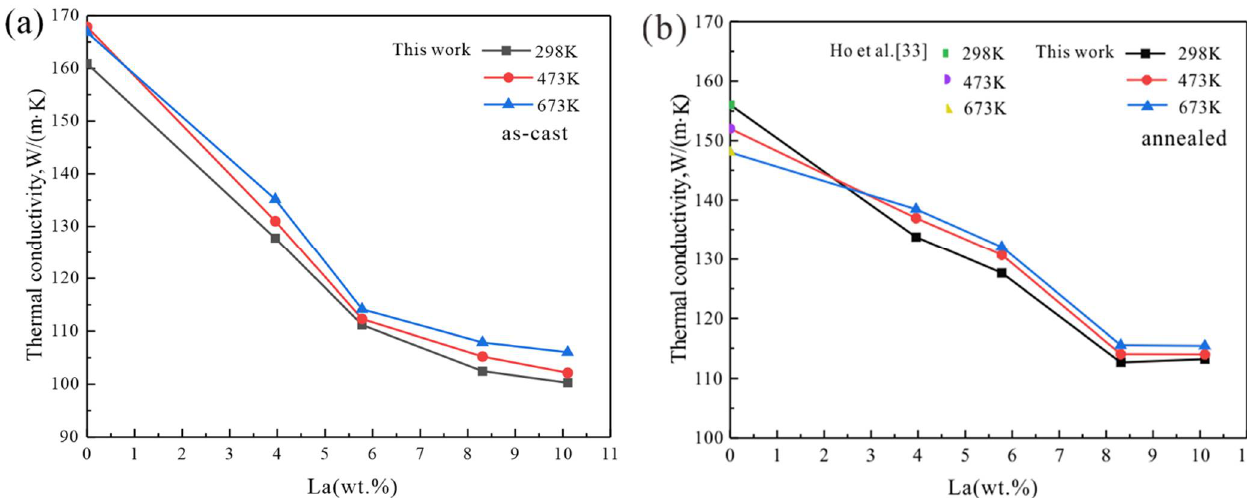
Figure 3. Thermal conductivity of ( a ) as-cast Mg-La alloys; ( b ) annealed Mg-La